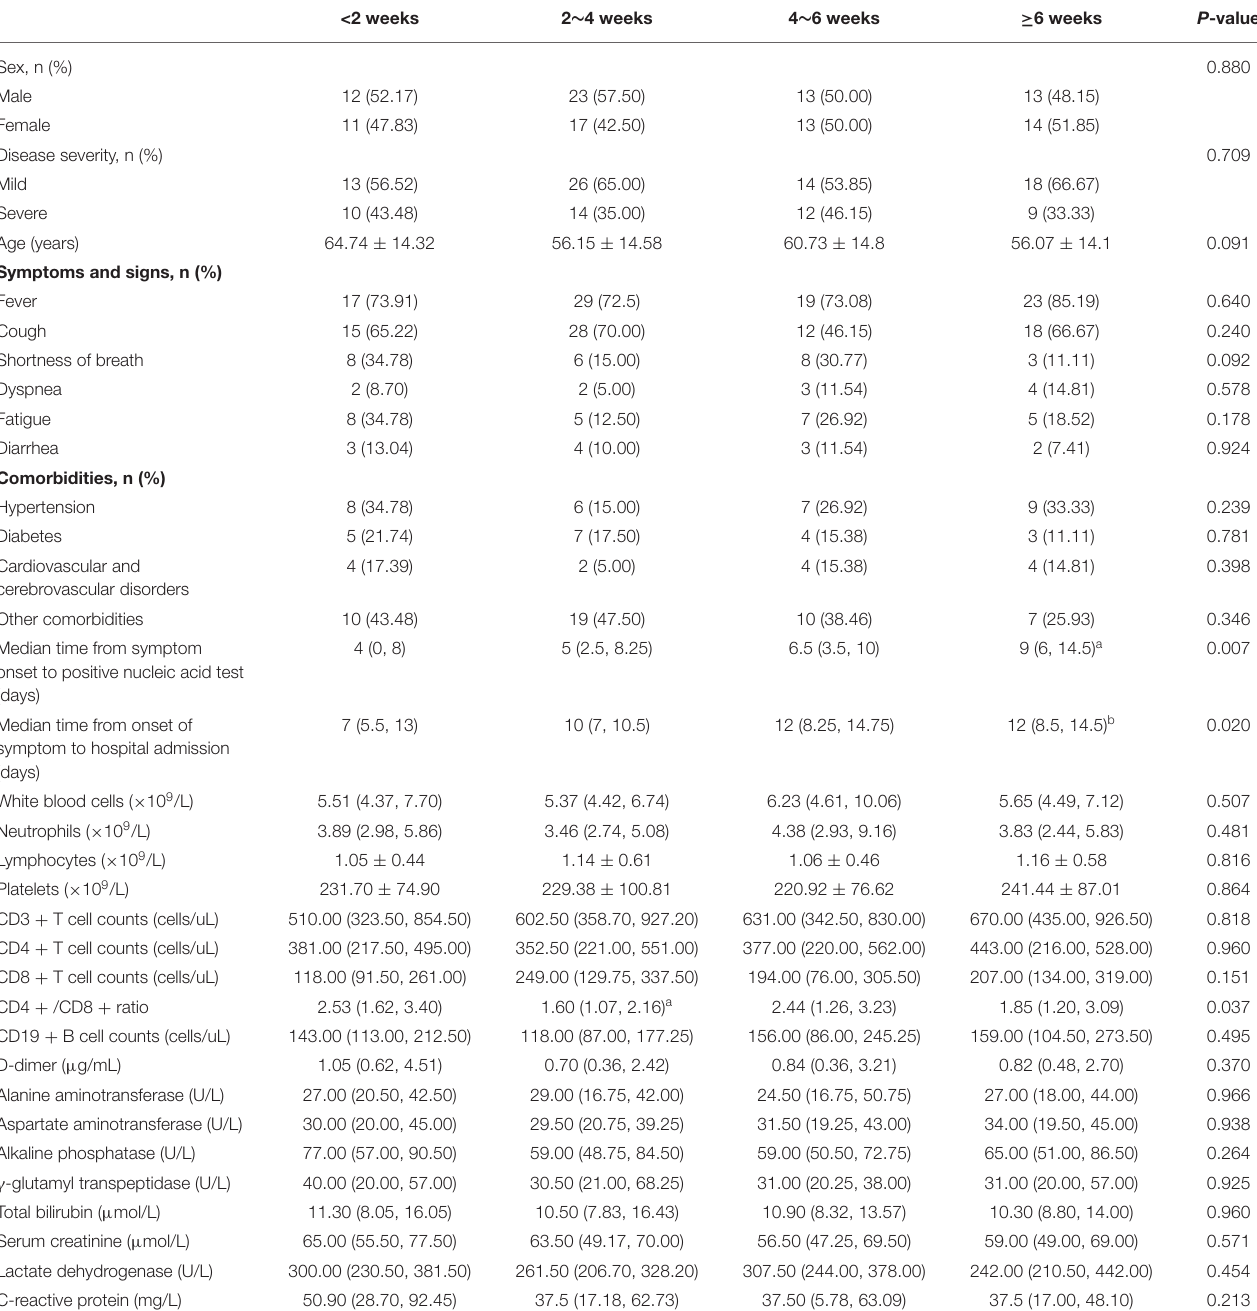
TABLE 3 | Comparison of clinical characteristics and laboratory findings among the four groups. <2